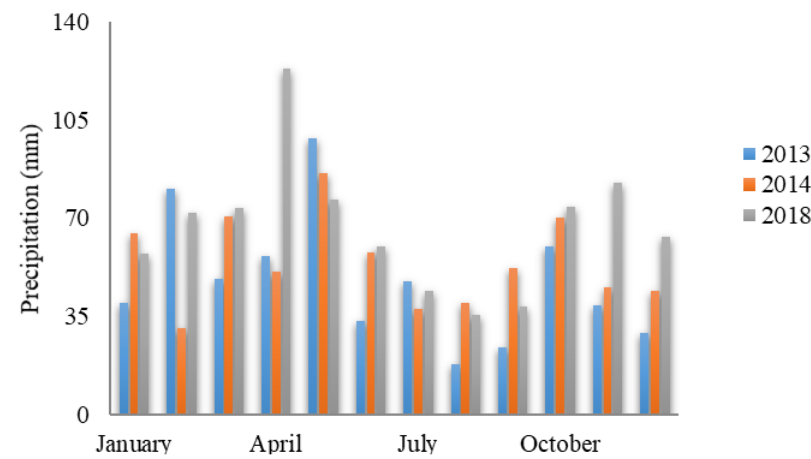
Figure 3. Average monthly precipitation.